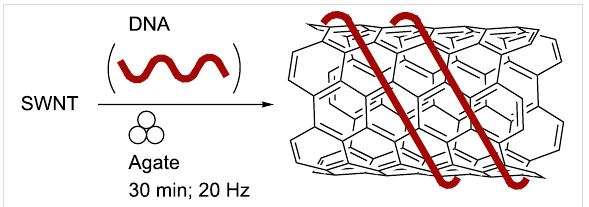
Figure 6: Structures of 5-fluorouracil (5FU) and nucleoside analogue prodrugs subject to mechanochemical co-crystal or polymorph transformation.